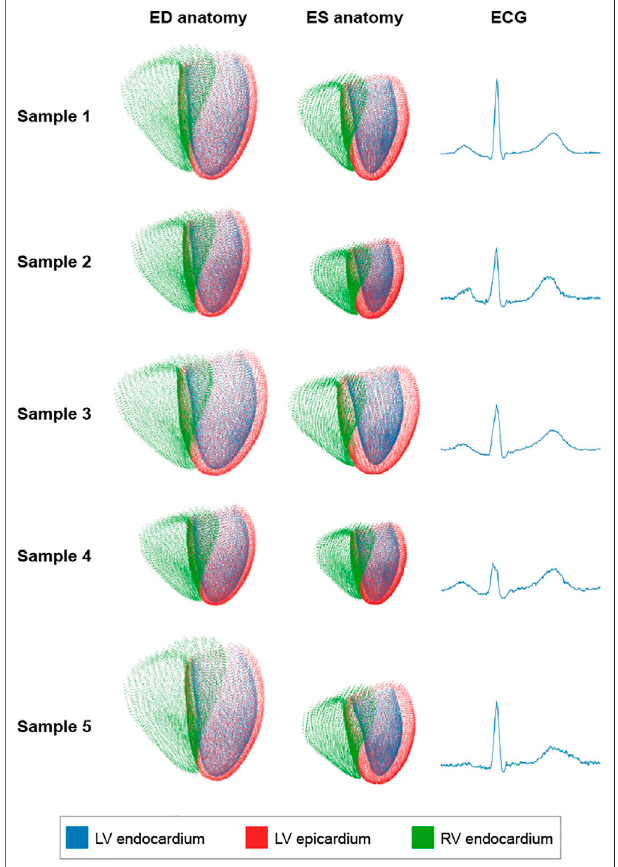
FIGURE 4 | Five randomly generated sample outputs where each row presents one